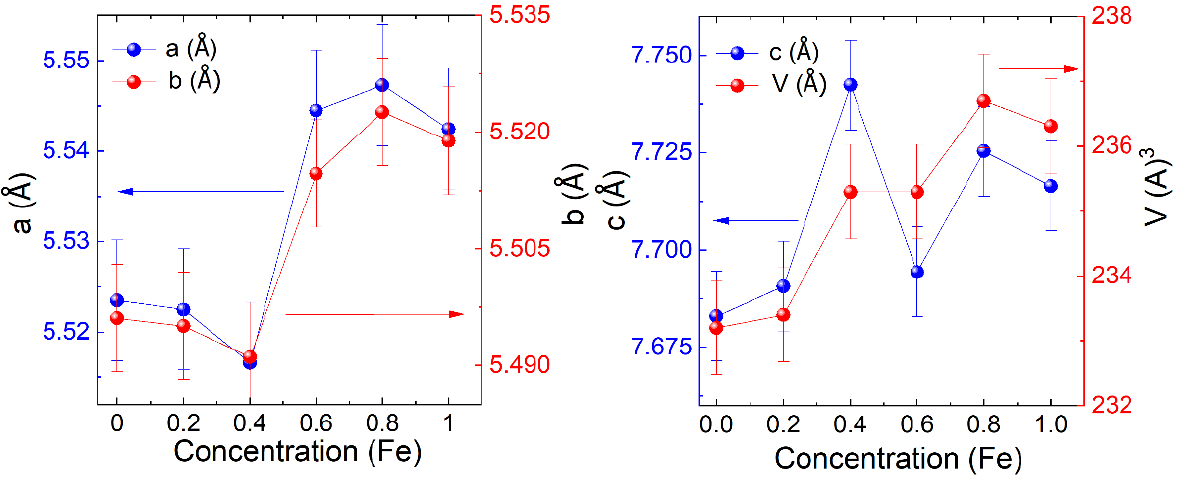
The plot of the lattice parameters versus the contents is shown in Figure 2. We found that the volume and grain size fluctuated with the increase in Fe +3 concentrations during refining the structural parameters. The average crystalline grain size of La 2 Co 1 − z Fe z MnO 6 (z = 0, 0.2–1.0) estimated the (2 0 0) peak with the help of the Scherrer formula given by Equation (1), and the values are listed in Table 1 [12]. k λ D = (1) β cos θ where k represents the geometry factor, and its value is considered as 0.9, θ is a diffracted Braggs angle, and β defines the full width at half maximum.